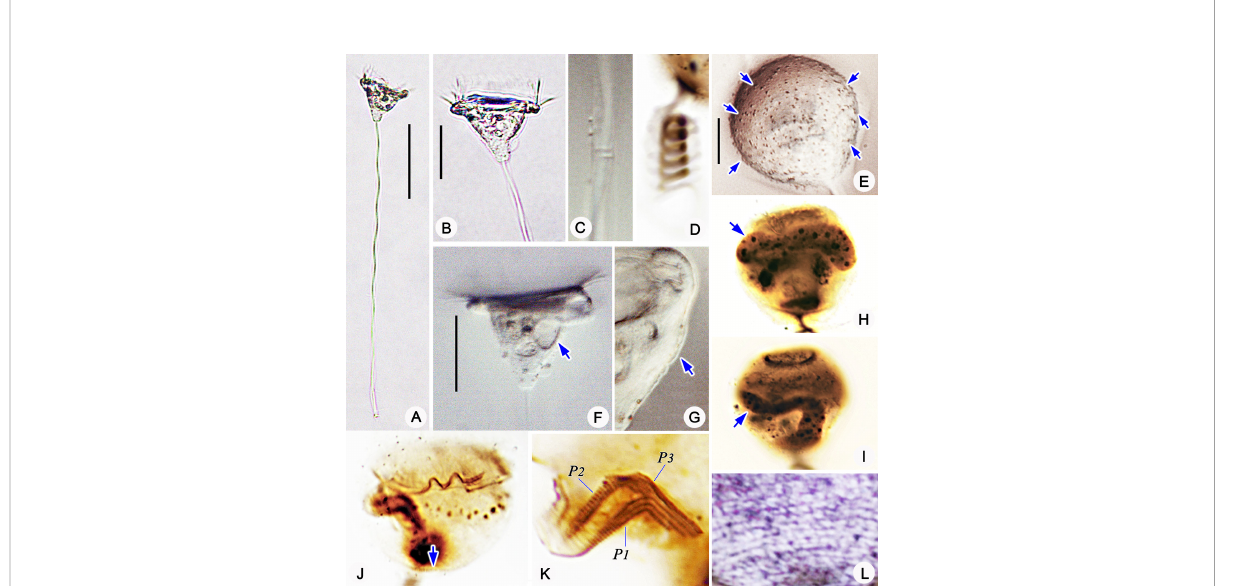
FIGURE 6 Photomicrographs of Pseudovorticella verrucosa in vivo (A – C, E – G) , after protargol staining (H – K) and after silver nitrate staining (L) . (A) A typical complete individual. (B) Zooid in typical shape. (C) Details of the stalk and spasmoneme. (D) Helically contracted stalk. (E) Pellicular granules (arrows). (F) Arrow marks the contractile vacuole. (G) Pellicular blisters (arrow). (H – I) Arrows point to the macronucleus. (J) Overview of the ciliature; arrow marks the aboral trochal band. (K) Infundibular part of the oral ciliature, showing the three polykineties. (L) Partial silverline system. P1 – 3, infundibular polykinety 1 – 3. Scale bars: 70 m m (A) , 30 m m (B, E) , and 10 m m (D)